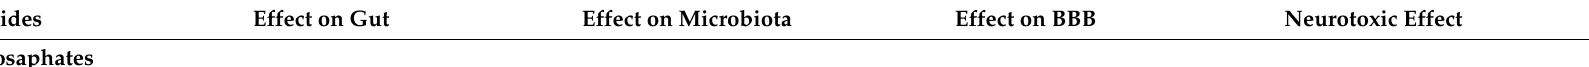
Table 1. Neurotoxic effects and impact of pesticides on the gut-microbiota-BBB axis. AChE: acetylcholinesterase; BBB: blood–brain barrier; C57BL/6: C57